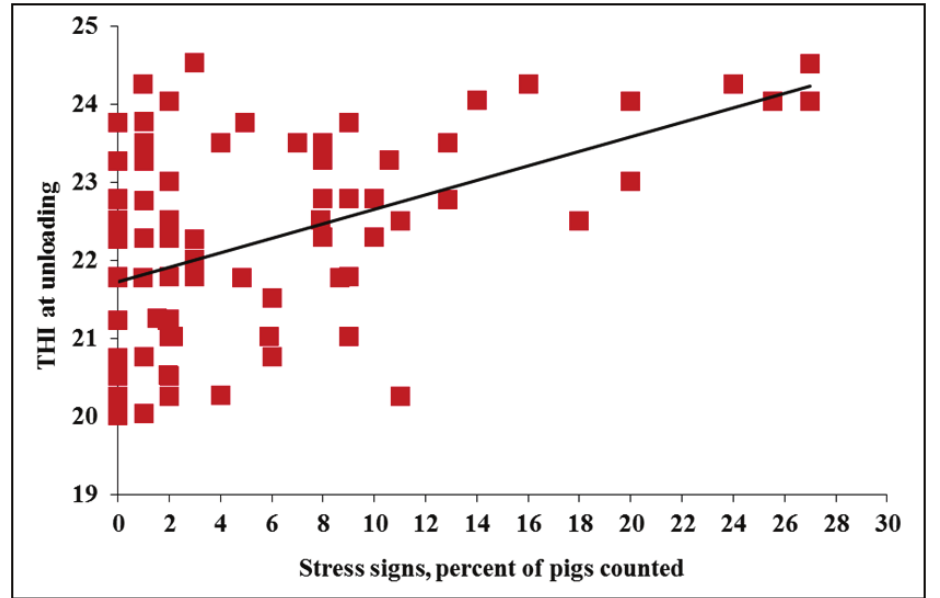
Figure 3. Experiment 1. Effects of THI at unloading on stress signs of market weight pigs at unloading in HOT weather ((cid:2)26.7 °C; p < 0.01, R 2 =